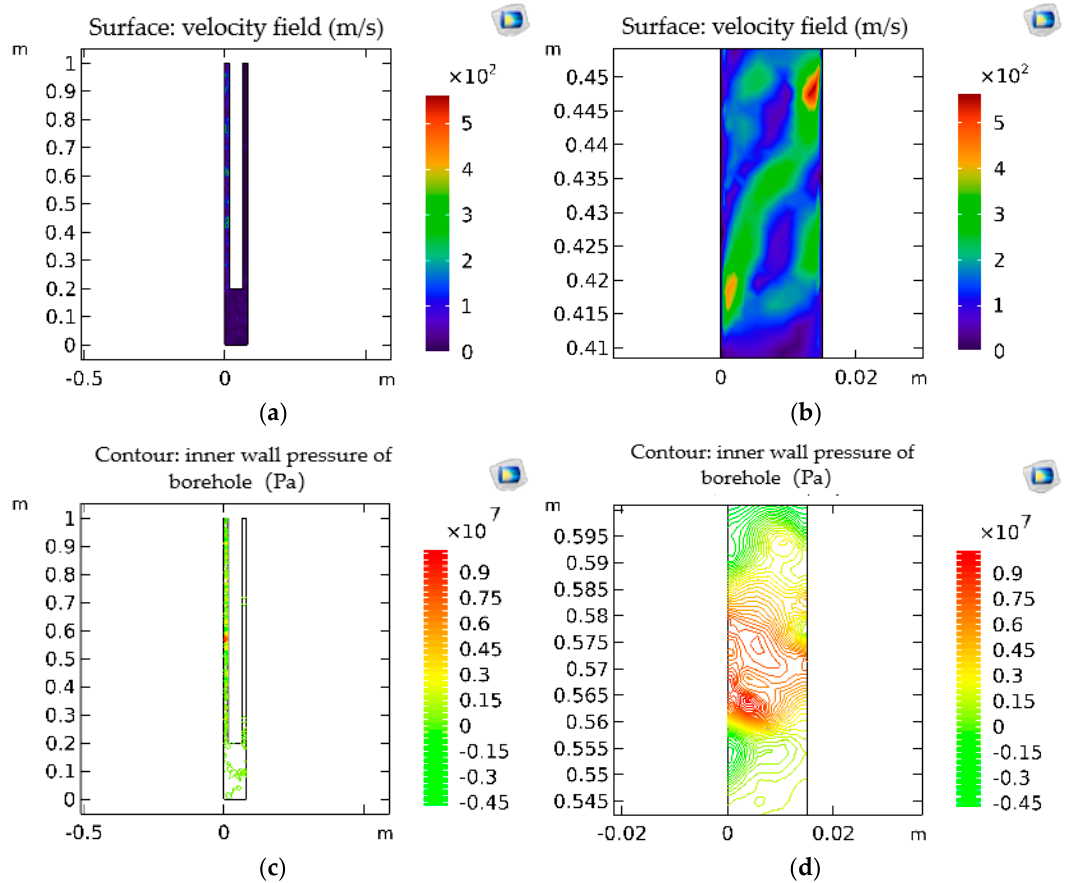
Figure 3. Fluid–solid coupling boundary state of 0.08 m borehole. ( a ) Surface velocity of inner wall of 0.08 m borehole. ( b ) Surface velocity of inner wall of 0.08 m borehole (velocity peak position). ( c ) Hole wall pressure of 0.08 m hole diameter. ( d ) Hole wall pressure of 0.08 m hole diameter (stress peak position).